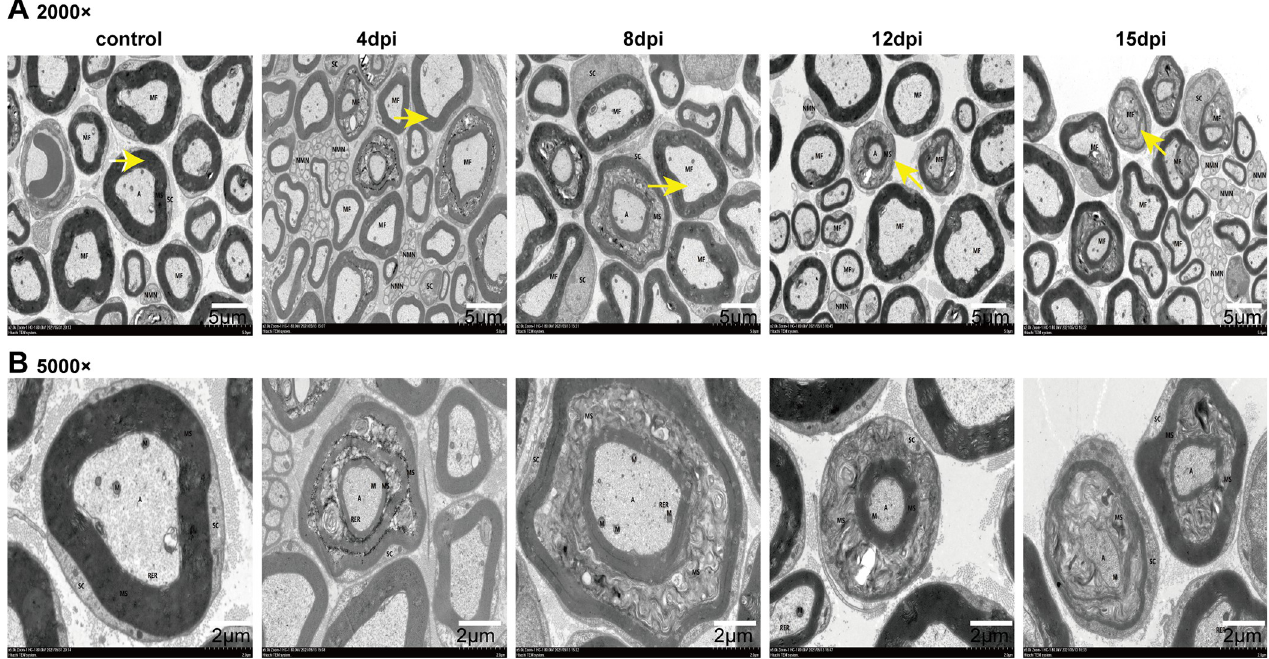
Fig 4. Ultrastructural of sciatic nerve of mice at different time. (A) 2000 × Magnification; (B) 5000 × Magnification. Magnified image of the arrowhead in (A). (MF) Myelinated nerve fiber, (NMN) Nonmyelinated nerve, (MS) myelin sheath, (A) axon, (SC) Schwann cells, (M) mitochondria, (RER) Endoplasmic reticulum